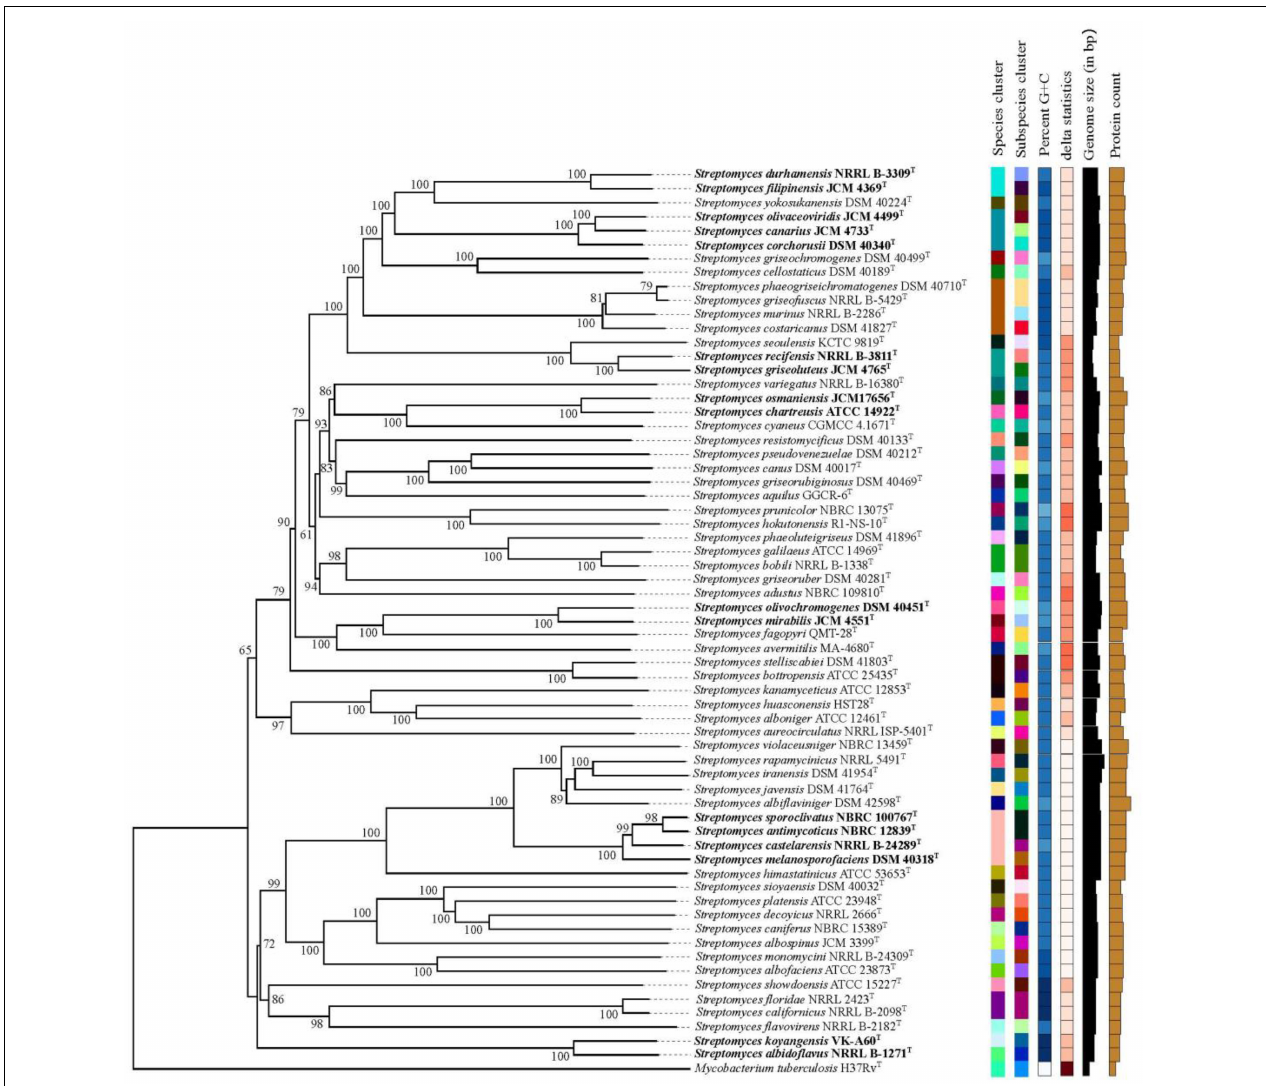
FIGURE 2 | Phylogenomic tree of five pairs of Streptomyces species and related reference strains. The numbers above branches are GBDP pseudo-bootstrap support values > 60% from 100 replications, with an average branch support of 96.0%. The tree was rooted at the midpoint (Farris,